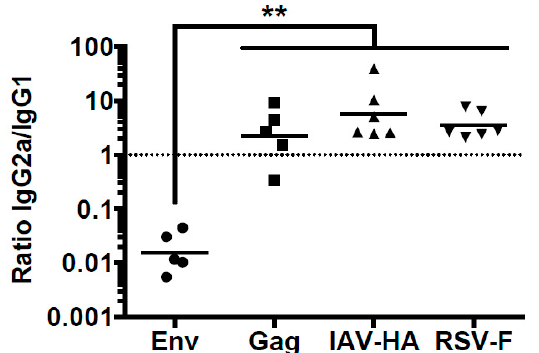
Figure 2. Differential humoral immune responses after DNA immunizations. Balb/c mice were immunized with either a combination of Env- and Gag-encoding plasmids (Hgpsyn and pConBgp140GC/D), or with RSV-F- or IAV-HA-encoding plasmids. Two weeks after the second immunization, antigen-specific IgG1 and IgG2a were determined via ELISA for each antigen separately and IgG2a/IgG1 ratios were calculated. Each Symbol represents an individual animal and geometric means are indicated by the solid lines. ( n = 5–6, ** p < 0.01; Kruskal-Wallis with Dunn’s post-test).